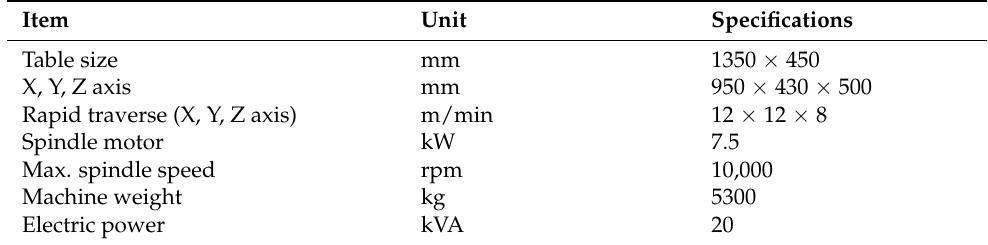
Table 1. Computer numerical control (CNC) machine